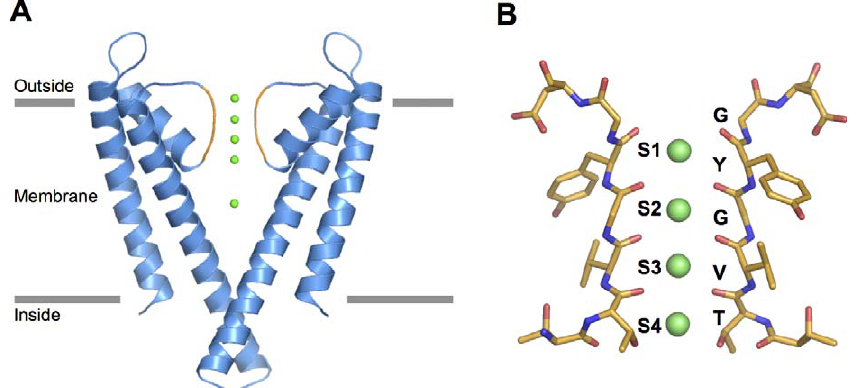
Figure 1. K þ Ion Binding Sites within the KcsA K þ Channel (A) A ribbon representation of KcsA with two of the four subunits is shown; the subunits closest to and furthest from the viewer are removed for clarity. K þ ions (in green) are located within the selectivity filter (orange) and in the water-filled cavity. The gray lines indicate the presumed interior and exterior membrane boundaries. (B) A stick representation of the selectivity filter containing four K þ ion-binding sites (S1–S4). Each K þ ion-binding site is composed of eight oxygen atoms made from the K þ channel TVGYG signature sequence. The figure was made using PyMOL